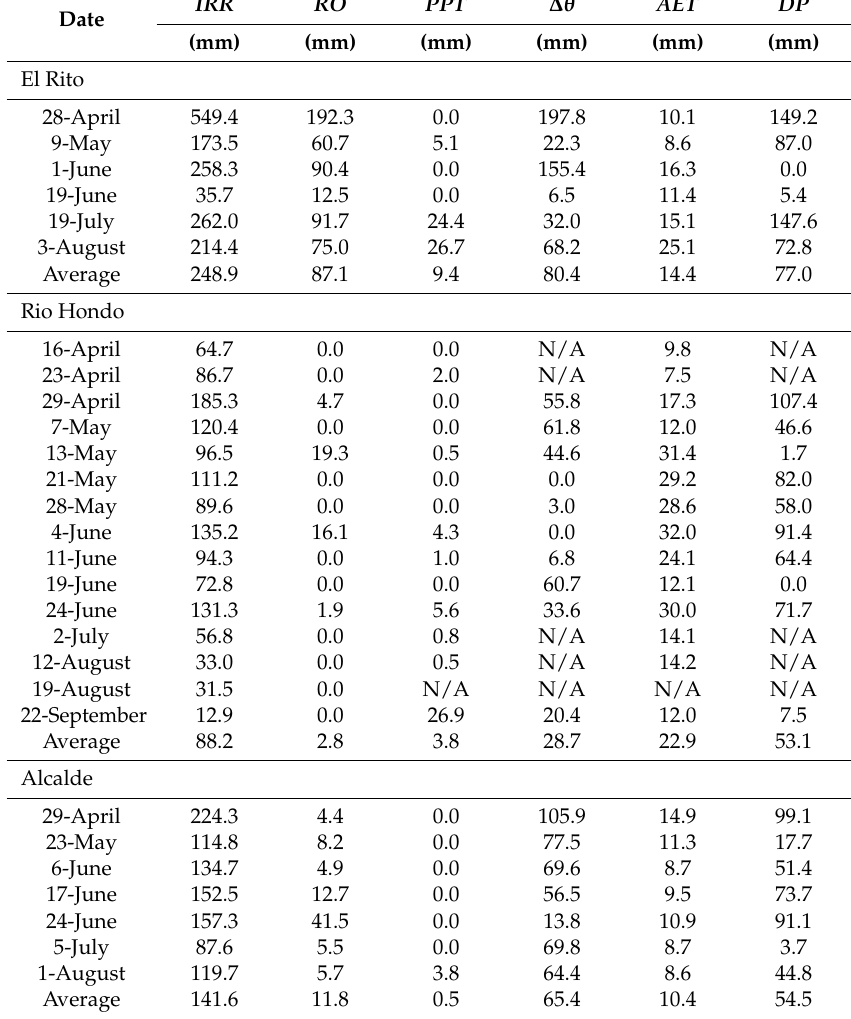
Table 3. Deep percolation ( DP ) results by the water balance method for the three study sites, El Rito, Rio Hondo, and Alcalde, showing total irrigation application ( IRR ), precipitation ( PPT ), change in soil volumetric water content ( ∆ θ = ( θ 24h − θ i )), and total evapotranspiration ( AET ) from the start of irrigation to 24 h after the end of irrigation. N/A = Data Not